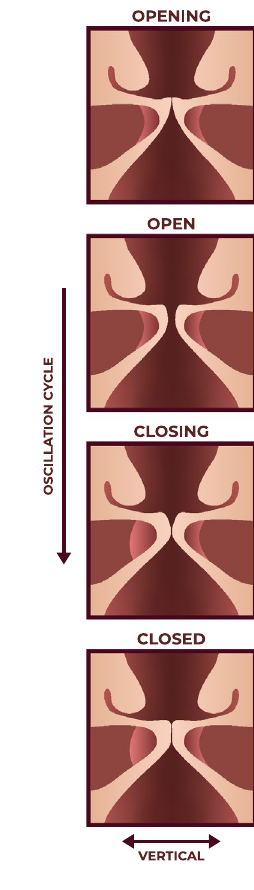
Figure 1. Schematic illustration: recording of the vocal fold vibration by means of High -Speed Videolaryngoscopy using ( A ) rigid endoscope, ( B ) flexible endoscope, ( C ) image of one vibration cycle of the vocal folds during